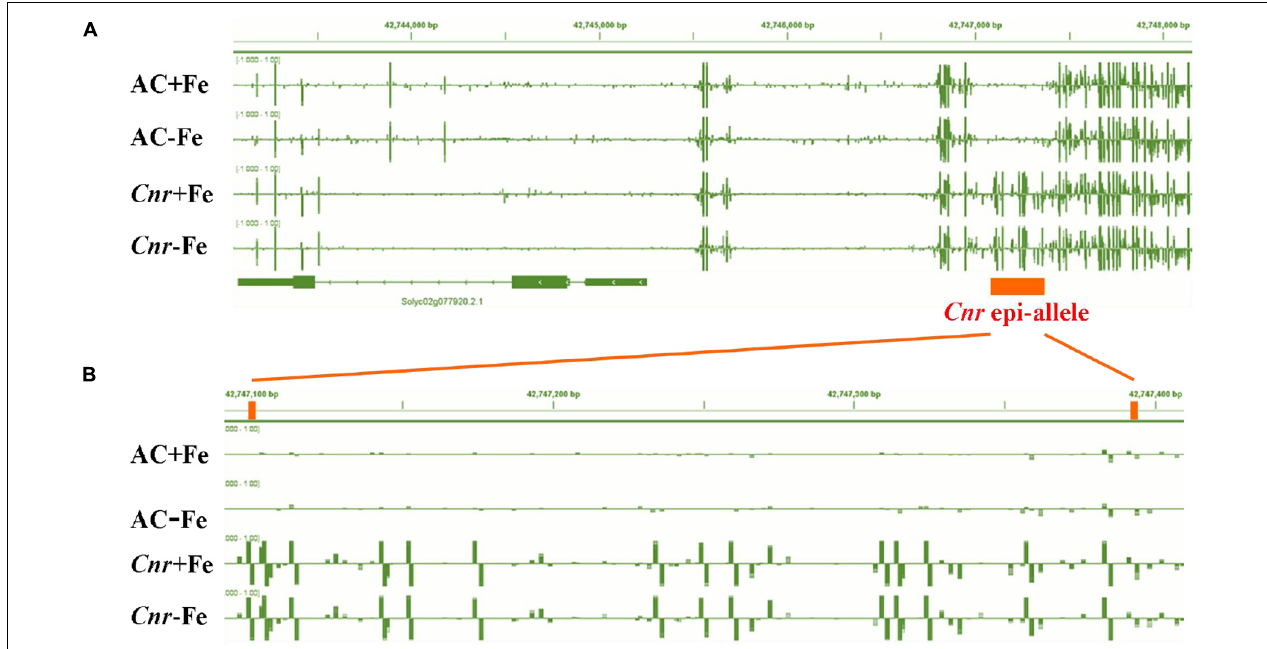
FIGURE 4 | Fe deficiency induced no significant changes in DNA methylation at the overall region of SlSPL-CNR gene in Cnr roots. Targeted bisulfite sequencing reveals changes of DNA methylation at the overall region of SlSPL-CNR gene (A) and the 286-bp epi-allele region of SlSPL-CNR promoter (B) in AC and Cnr roots after 3 days under +Fe or –Fe condition. Bar-chart shows the methylation levels in the SlSPL-CNR gene locus. The location of the Cnr epi-allele in the promoter region of SlSPL-CNR is